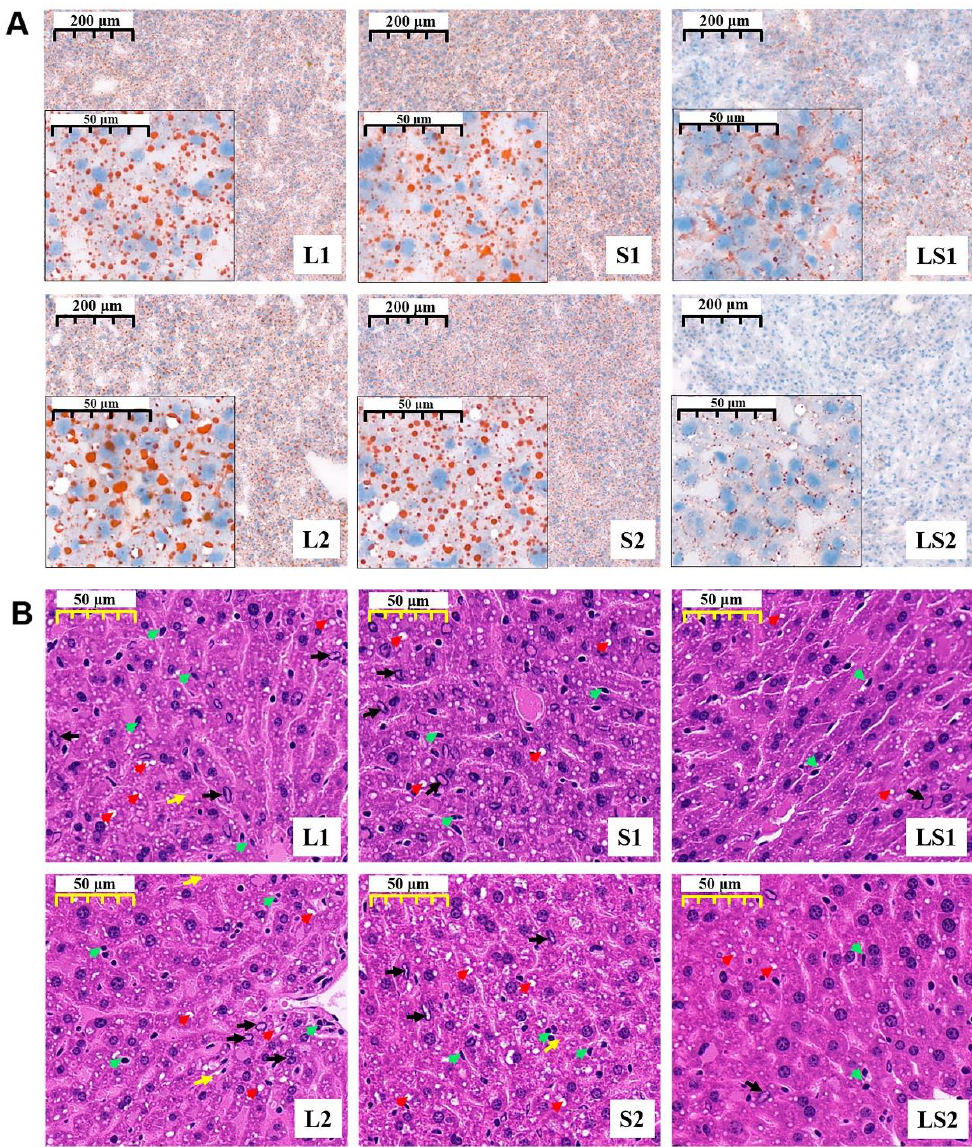
Figure 5. Impacts of various oil/fat diets on liver ( A ) liver oil red staining (magnification 50 × and 400 × ) and ( B ) hematoxylin–eosin staining in mice during a period of 16-week intervention (magnification 200 × ). Red arrow—circular cavity; green arrow—inflammatory cells; black arrow— edge set of chromatin; yellow arrow—focal infiltration of